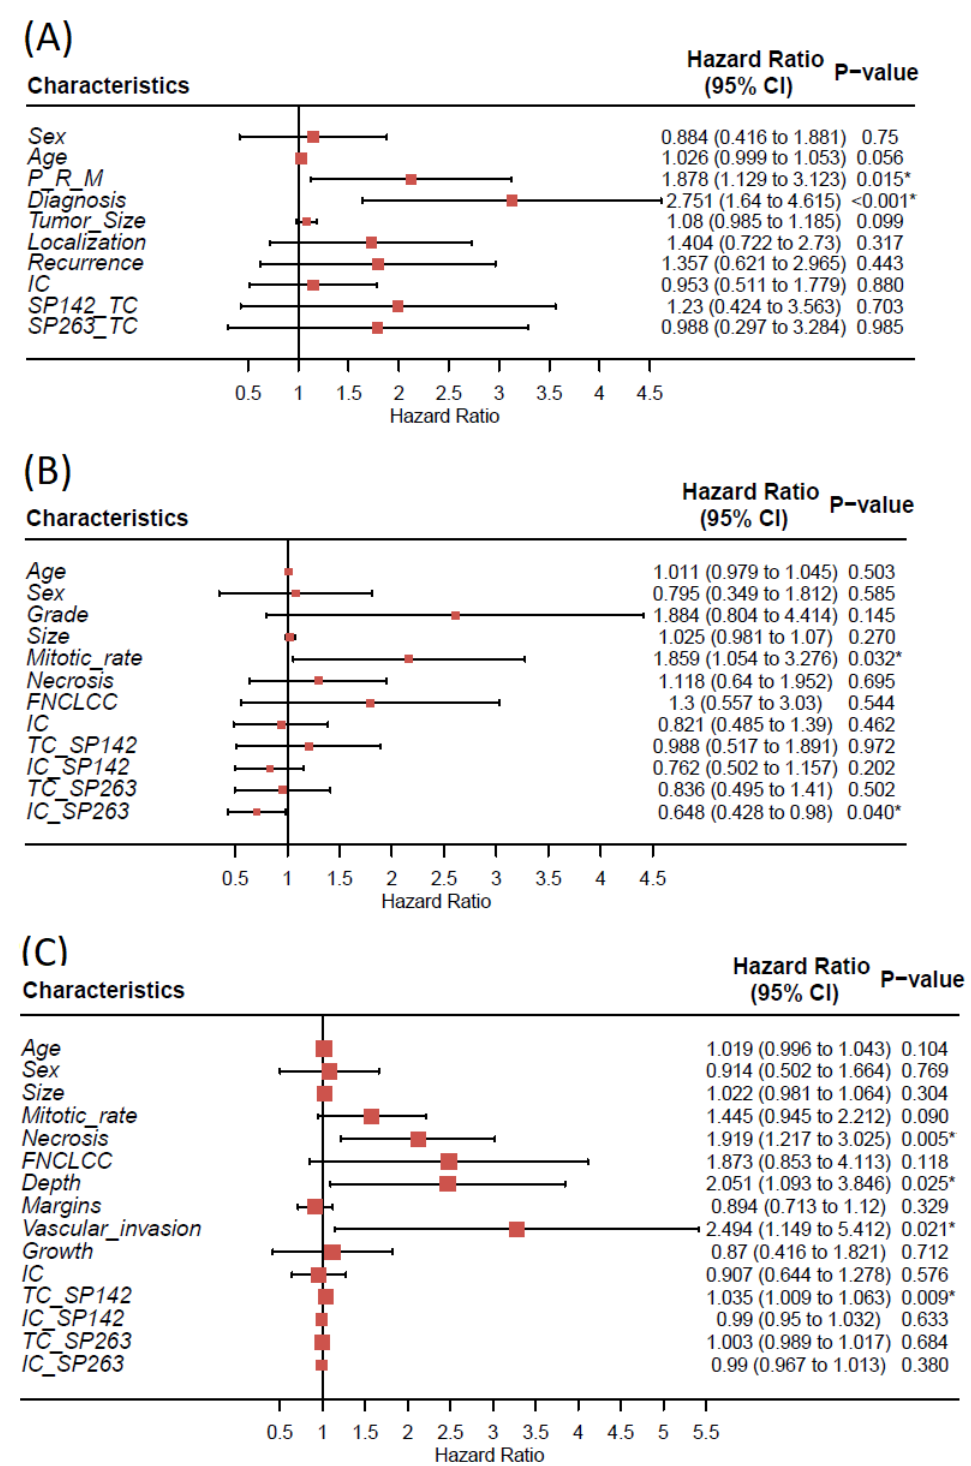
Figure A2. Univariate analysis of association between clinical/tumor characteristics, PD-L1 immunoreactivity and metastasis-free survival (MFS) of ( A ) chondrosarcoma, ( B ) liposarcoma and ( C ) undifferentiated pleomorphic sarcoma (* = p < 0.05).